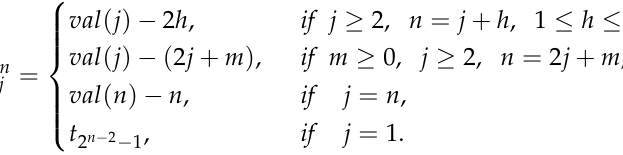
Table 1. Valencies val ( i ; Γ j